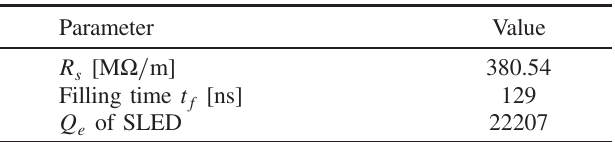
TABLE III. Optimal CG structure parameters using analytical expressions (11) – (14).